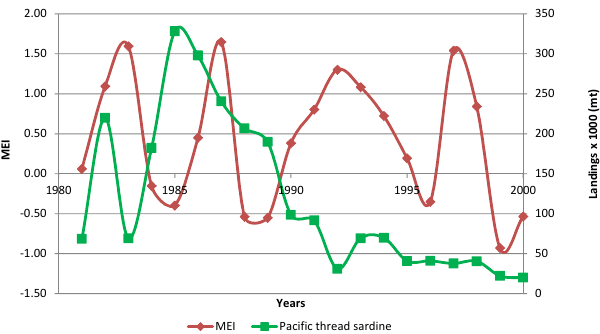
Figure 12. Landings (mt) of Pacific thread sardine (pinchagua) and its relationship with MEI in